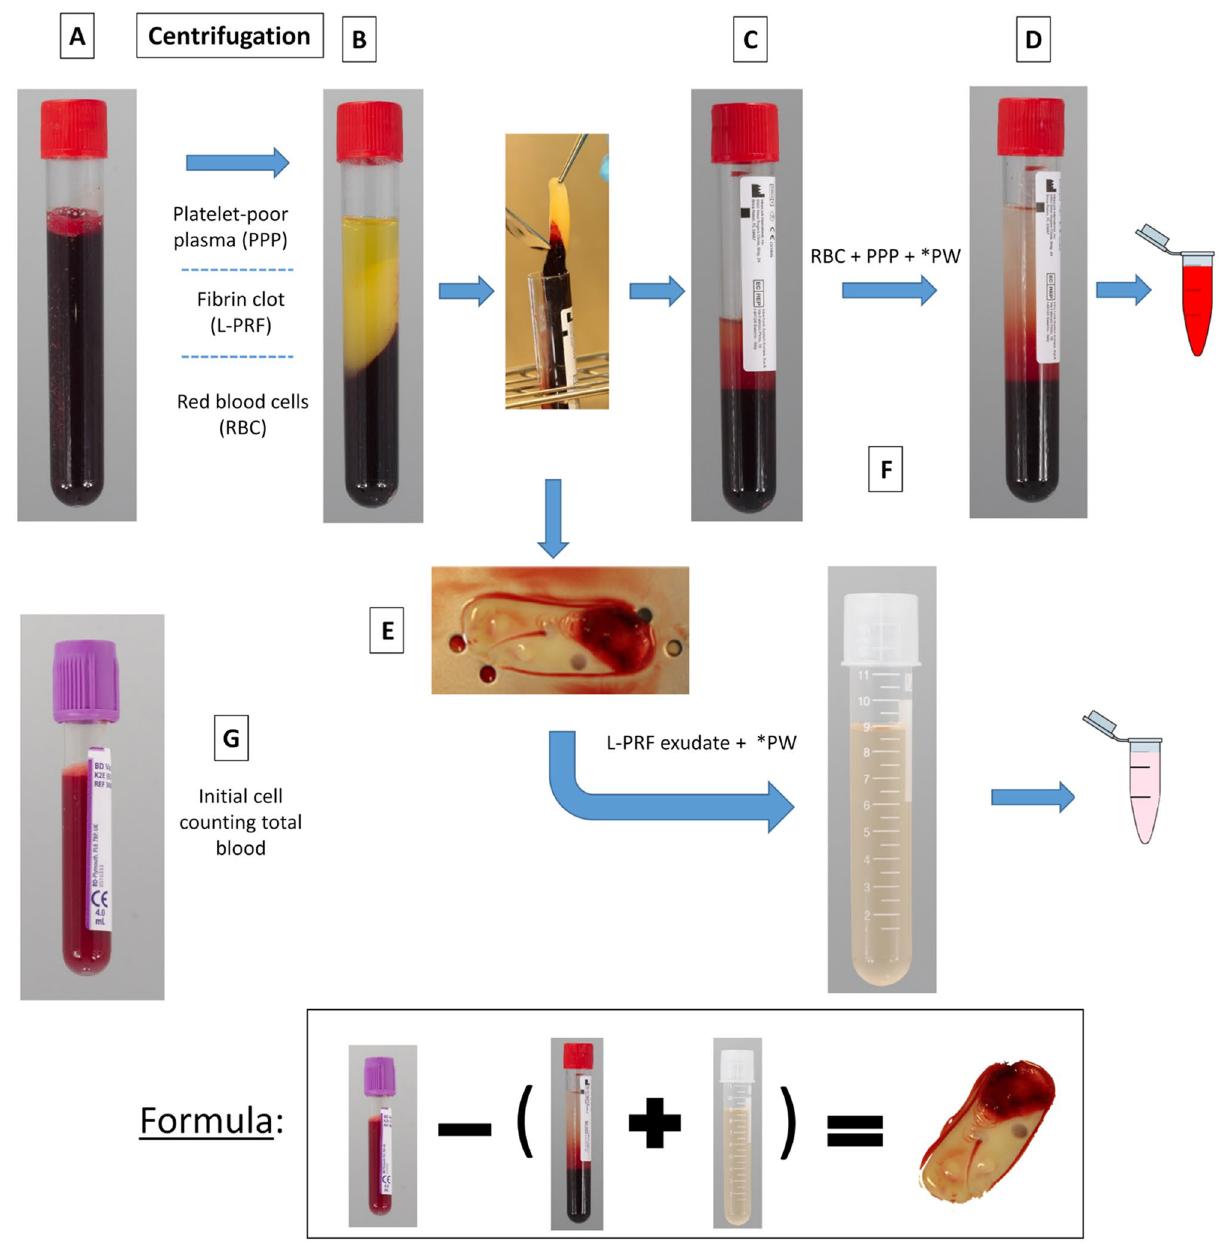
Figure 7. Representation of steps for cellular counting. ( A ) initial blood; ( B ) tube after centrifugation with three layers: platelet-poor plasma (PPP), fibrin clot (L-PRF clot), and red blood cells (RBC); ( C ) tube after removal of the fibrin clot (PPP + RBC). ( D ) same tube of step C with physiological water (PW) until a volume of 9 ml (initial volume); ( E ) L-PRF membrane prepared after compression of the clot; ( F ) tube with L-PRF exudate release during the compression of the L-PRF clot + physiological water (PW) until a volume of 9 ml; (G) tube with initial blood